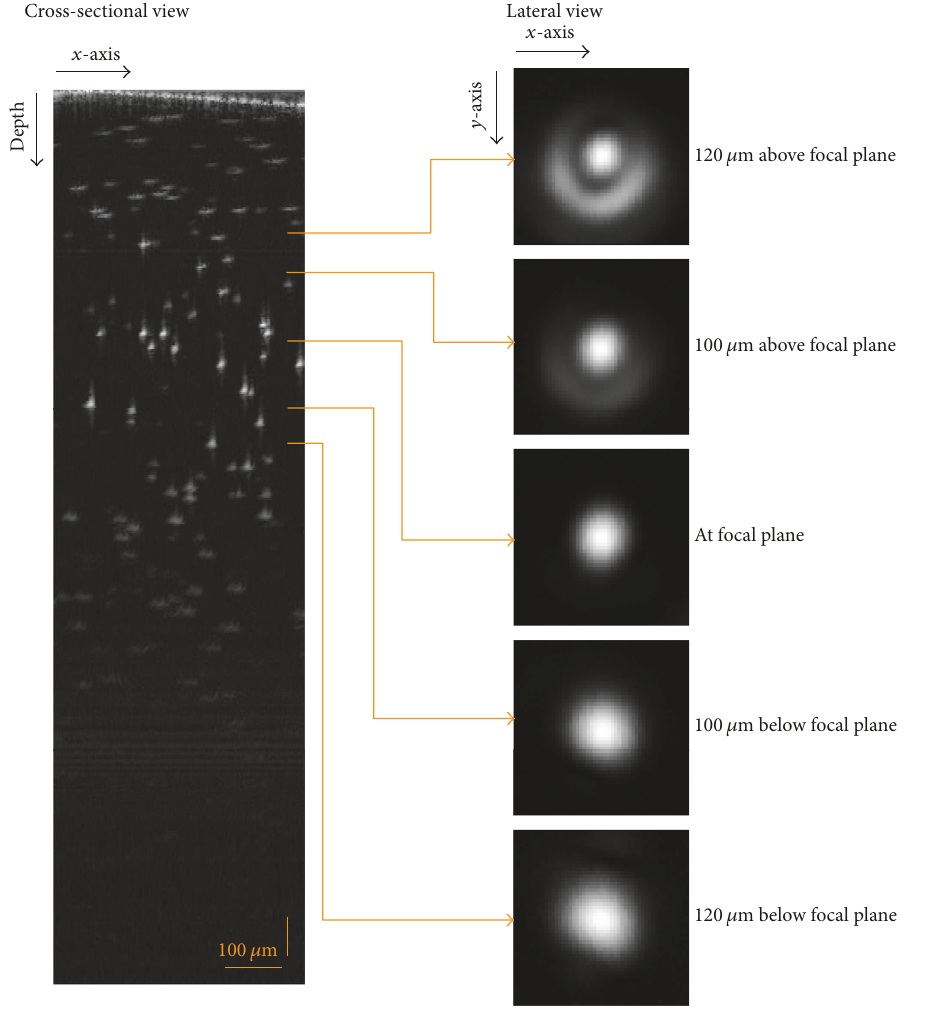
Figure 8: The lateral point spread function (PSF) of the custom-made OCT scanner. The PSF was measured using a gold nanoshell embedded phantom when the focal plane was placed ∼ 390 𝜇 m below the surface of the phantom. The lateral PSF includes some rings at regions above the focal